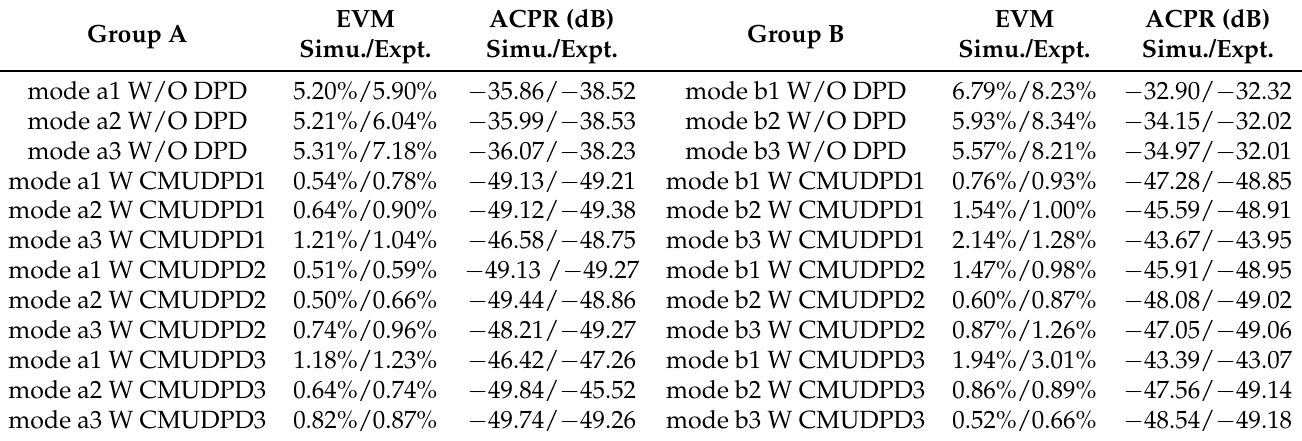
Table 3. The simulation (simu.) and experimental (expt.) results of CMUDPD in Group A and Group B with each of the three modes as feedback